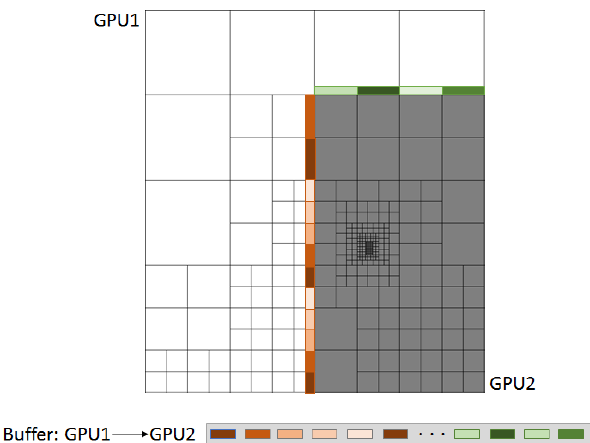
Figure 11. Multi-GPU communication. GPU buffer data collected and packed for a single communication.